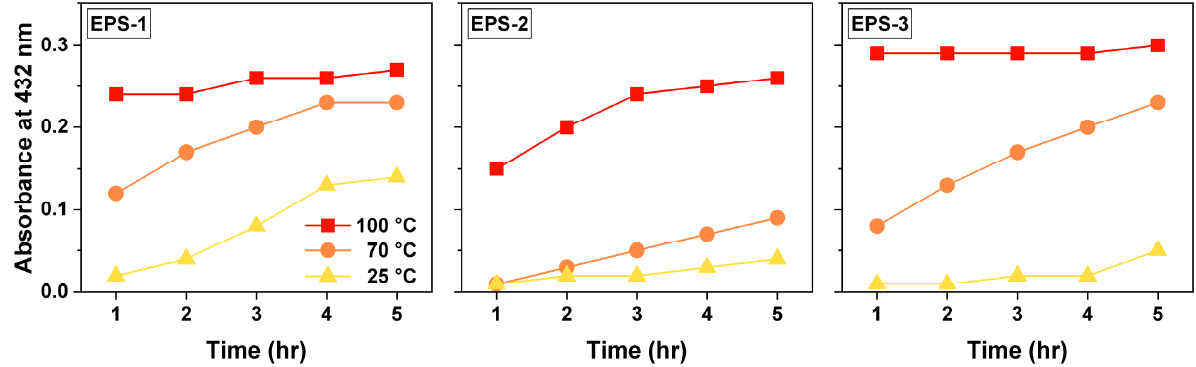
Figure 2. UV–Vis light absorbance at 432 nm of AgNO 3 and EPS solution mixture at 25, 70, and 100 °C, respectively. Each reaction mixture contained 10 mM AgNO 3 and 0.5 g L − 1 EPS.